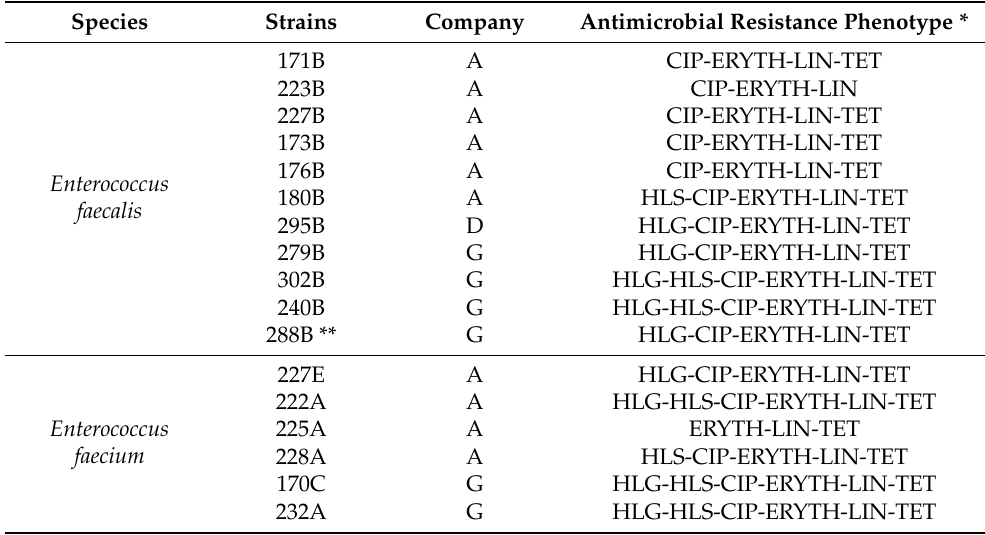
Enterococcus faecium